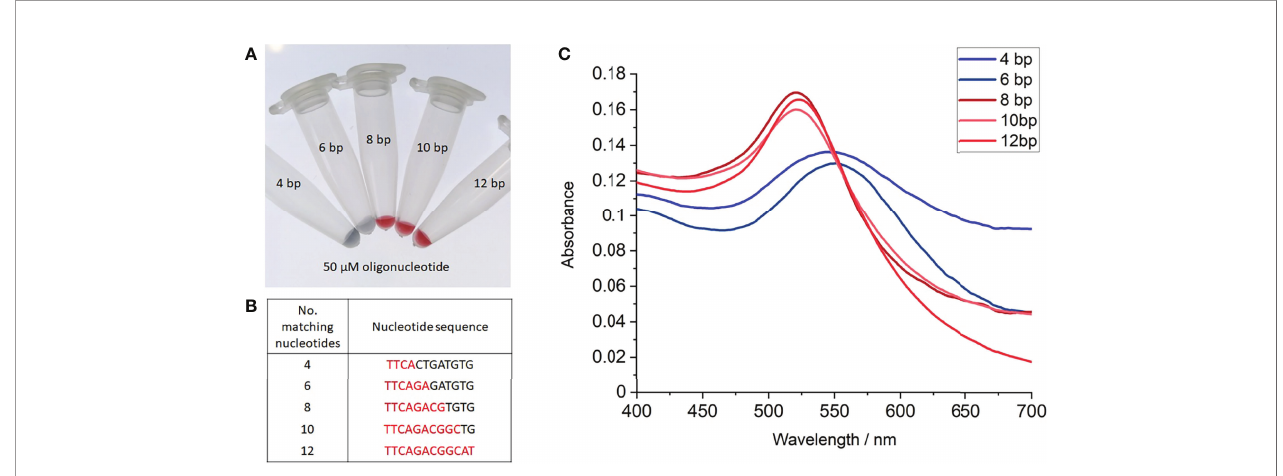
FIGURE 3 | Salt-induced aggregation tests with partial complementary oligonucleotides. (A) Photograph of gold nanoprobes after incubation with 50 µM of each oligonucleotide, heating to 95°C, before cooling to room temperature and treating with 40 mM MgSO 4 , (B) Table of partial complementary oligonucleotides used, (C) UV-vis absorption spectra of nanoprobe samples with each oligonucleotide. Each experiment was repeated 3 times, with photographs shown from 1